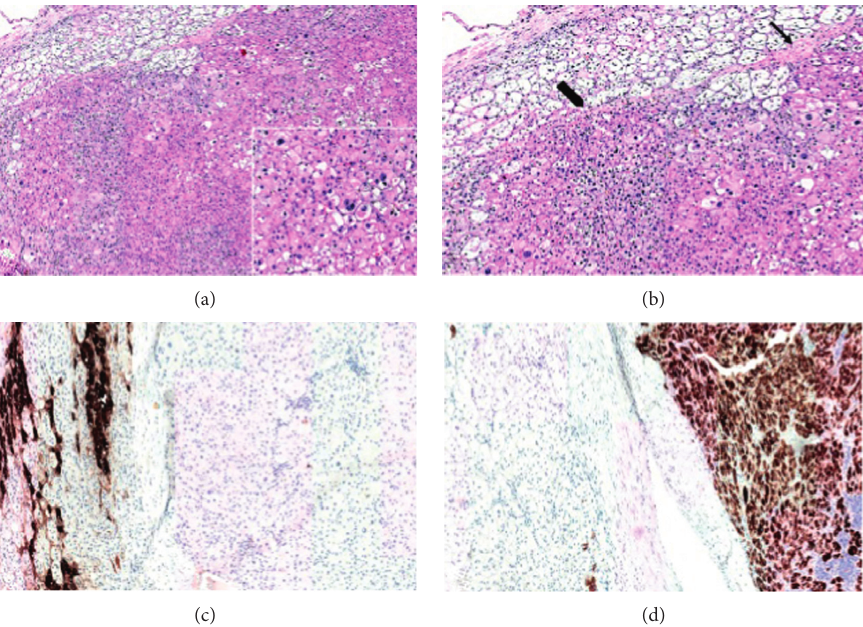
Figure 2: Histopathological features and immunohistochemical findings: (a) encapsulated diffuse proliferation of large cells with focal capsular invasion. Inset: the cells show pleomorphic nuclei, prominent nucleoli, and wide eosinophilic and granular cytoplasm. (b) At higher magnification, capsular invasion is shown in detail (the arrow signs a thin fibrous capsule dividing the neoplasm from the cortex of the adrenal gland, while the thick arrow shows the focal infiltration of the adrenal parenchyma by the tumour). (c) The neoplastic cells resulted negative for chromogranin A (positive internal control: adrenal medulla). (d) The neoplastic cells resulted strongly and diffusely positive for inhibin A (internal control: adrenal cortex, mild and sparse positivity). (a, b) Haematoxylin-eosin stain. (c) Chromogranin A. (d) Inhibin